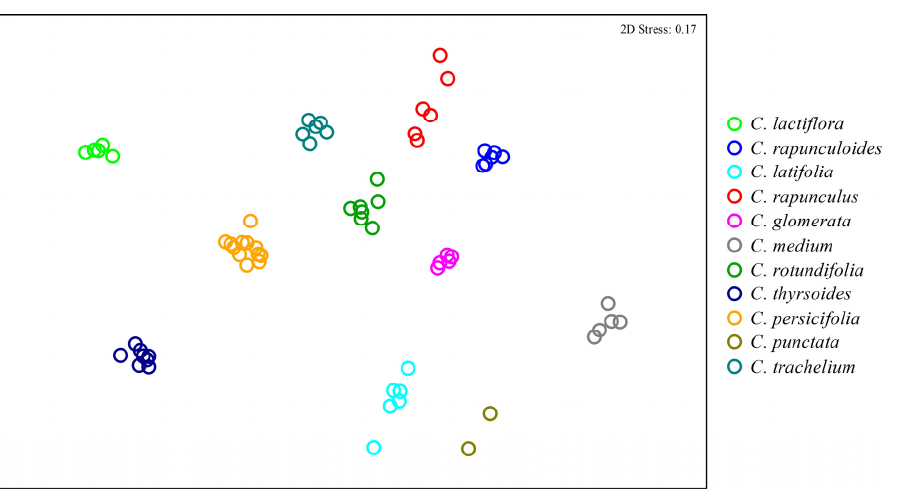
Figure 2. Comparison of floral scent bouquets among 11 Campanula species based on semi- quantitative Bray–Curtis similarities plotted with non-metric multidimensional scaling (NMDS). Samples grouped in a similar manner in the NMDS plot based on qualitative similarities (Figure S1, Supplementary